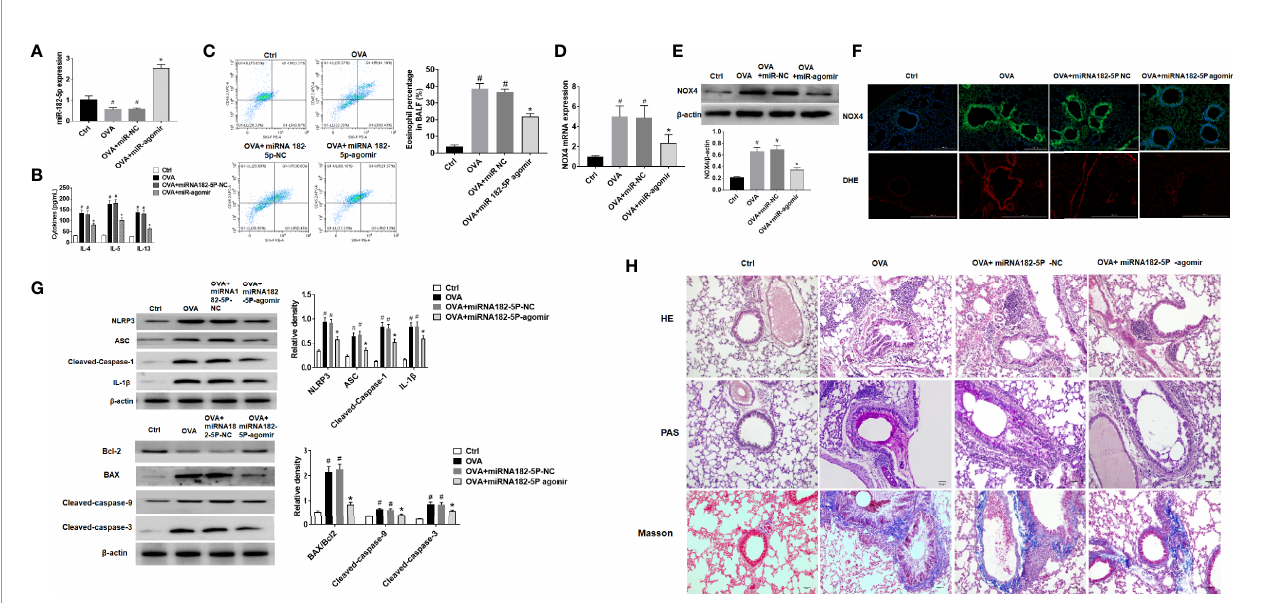
FIGURE 8 | MiRNA-182-5p inhibits in fl ammation in asthma models. (A) Real-time PCR analyzed miRNA-182-5p level in lung tissues after injection of miRNA-182-5p agomir; (B) The expression of Th2-type cytokines IL-4, IL-5, and IL-13 in BALF was determined by ELISA; (C) The percentage of eosinophils in BALF of different groups was measured by fl ow cytometry. All data were shown as mean ± SD (n = 8). (D) Real-time PCR was used to determine NOX4 mRNA expression in different group; (E) Western blot was used to determine NOX4 protein expression in different group; (F) The expression of NOX4 and ROS in lung tissue was observed by immuno fl uorescence and DHE. Scale bar: 200 µm; (G) Western blot was used to measure NLRP3 in fl ammasome-associated proteins NLRP3, ASC, Cleaved- caspase-1 and IL-1 b and apoptosis-associated proteins Bcl-2, BAX, Cleaved-caspase-9, and Cleaved-caspase-3 protein expression in lung tissues. (H) Lung tissue sections were stained with hematoxylin-eosin (HE) to observe in fl ammatory cell in fi ltration. Periodic acid-Schiff (PAS) was used to assess goblet cell hyperplasia. Sub- epithelial collagen deposition and fi brosis were assessed by Masson staining. Scale bar: 50 µm. All data were shown as mean ± SD (n = 3). # p < 0.05 versus control, * p < 0.05 versus OVA group as determined by one-way analysis of variance (ANOVA) and Dunnett ’ s post hoc